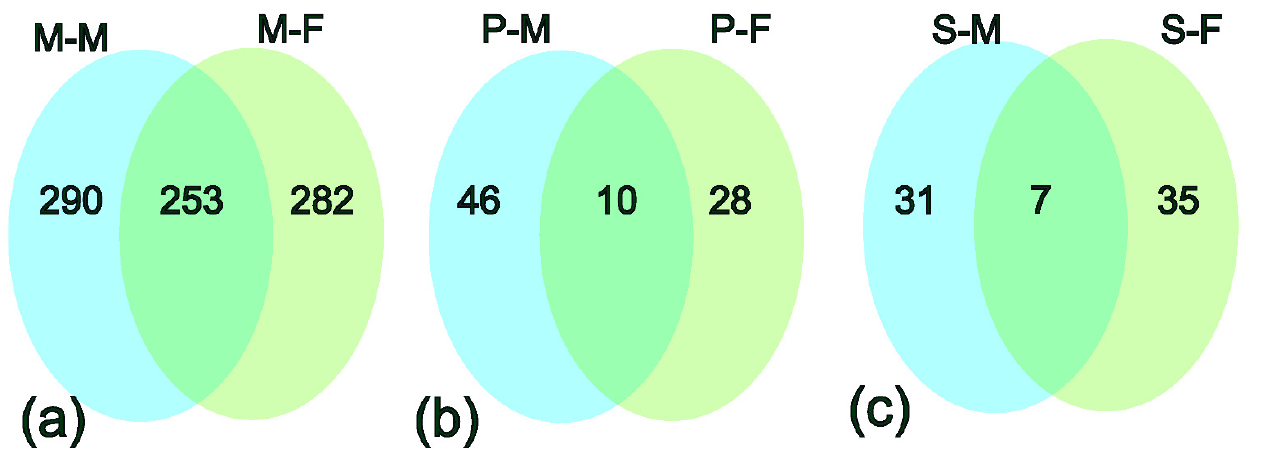
Figure 2. Distribution of uniquely expressed genes in each adipose tissue in male and female reindeer. ( a ) Shared and uniquely expressed genes in the metacarpal adipose tissue of male (M-M) and female (M-F) samples, ( b ) shared and uniquely expressed genes in the perirenal tissue of male (P-M) and female (P-F) samples, and ( c ) shared and uniquely expressed genes in the scapular tissue of male (S-M) and female (S-F)